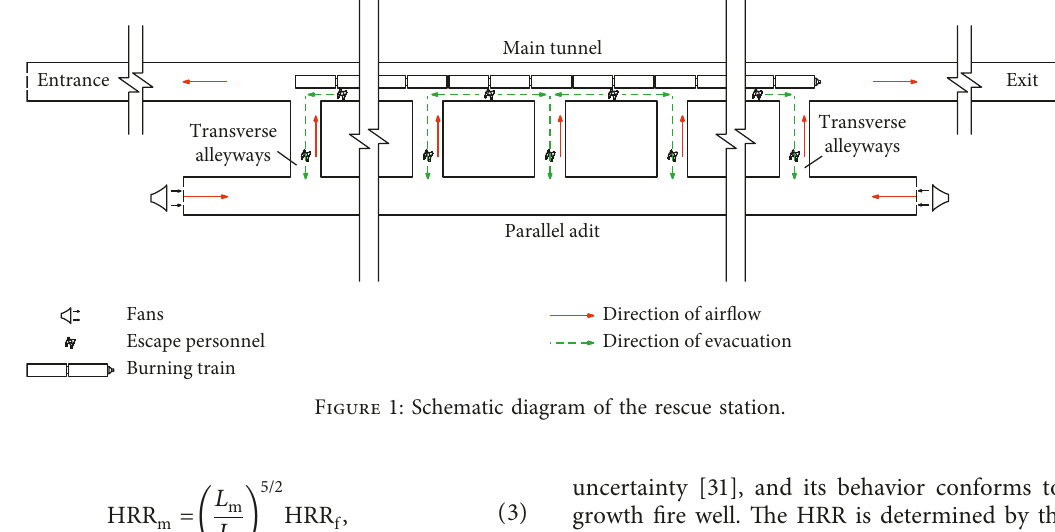
Figure 1: Schematic diagram of the rescue